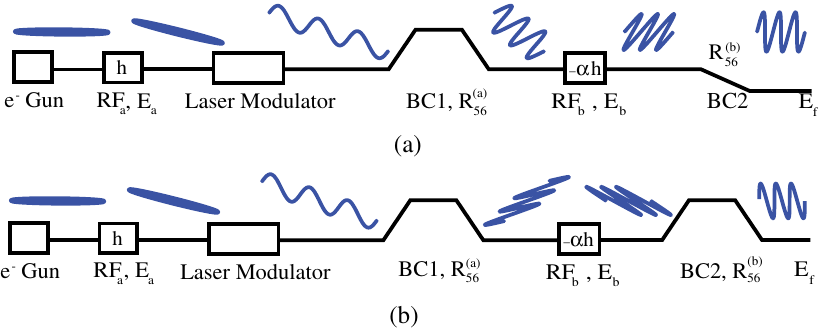
FIG. 1. Diagram of CHG scheme. (a) The first accelerator section raises the particle energy to E and introduces a linear chirp, h . a After modulating with a laser, the first dispersive section, BC1, compresses the beam and overbunches the modulation. A second rf , and cancels the chirp of the first section. The final dispersive section, BC2, unwinds the section accelerates the particles to E b overbunching. (b) Operating BC1 in overcompression rotates the electron beam head to tail, allowing the use of a chicane for both BC1 and BC2. In both cases it is possible to add a third accelerator section to reach a final energy of E f